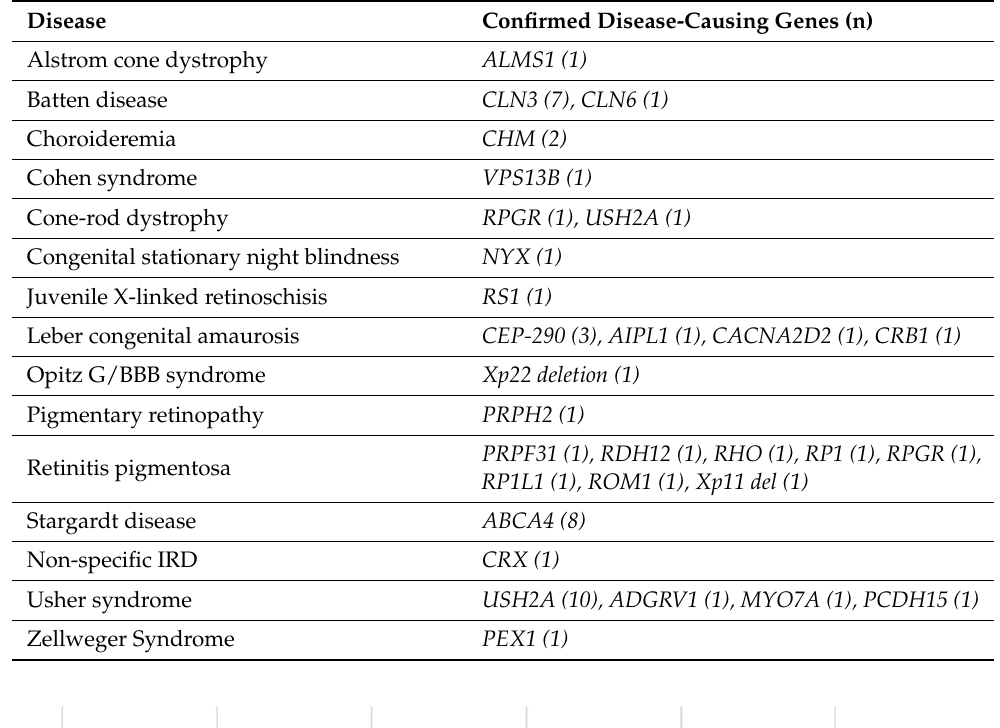
Table 1. Pathogenic genetic variants per retinopathy identified in our cohort.